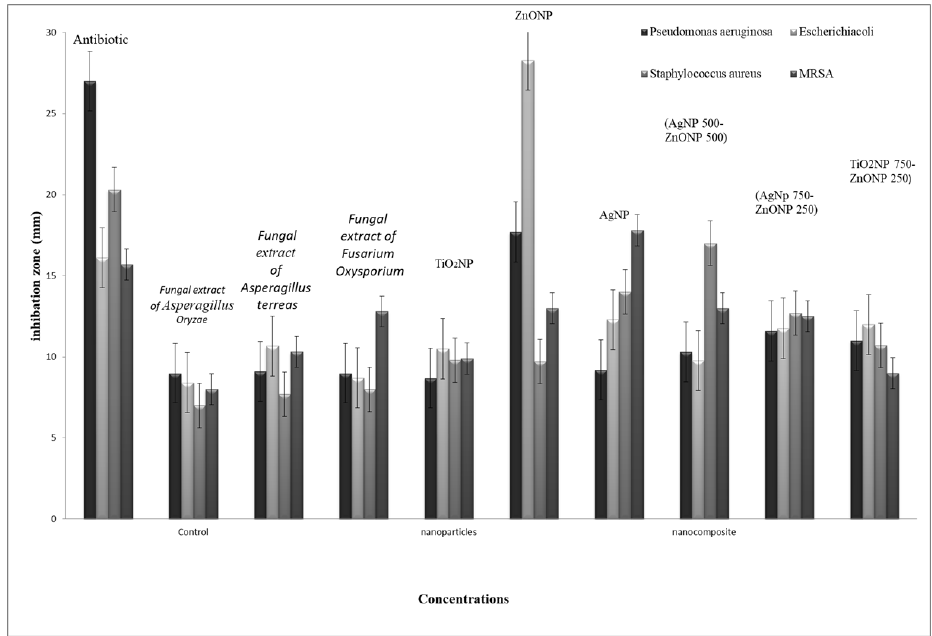
Figure 7. The inhibition zones of biosynthesized nanoparticles and capping nanocomposite. SD±, standard deviation.